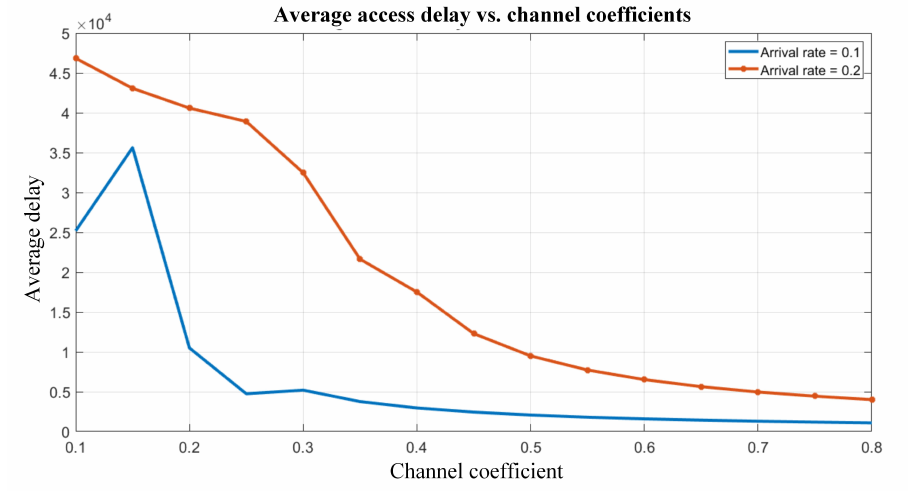
Figure 8. Delay vs. channel coefficient.